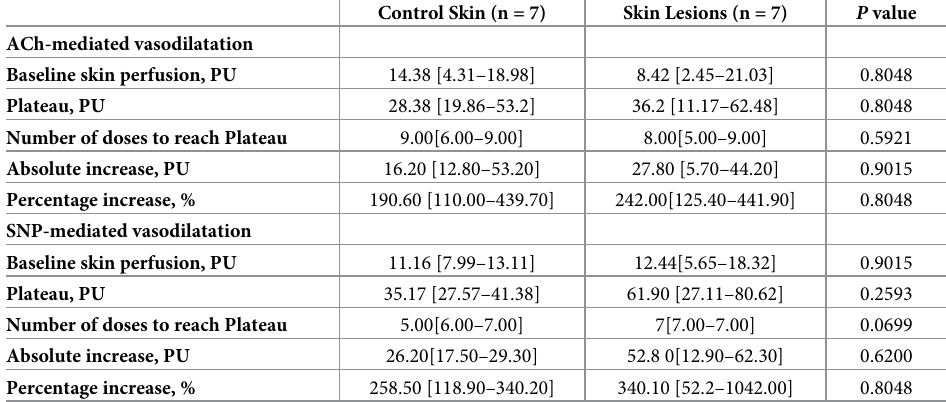
Data are expressed as median [interquartile range]. ACh: acetylcholine. SNP: sodium nitroprusside. PU: perfusion